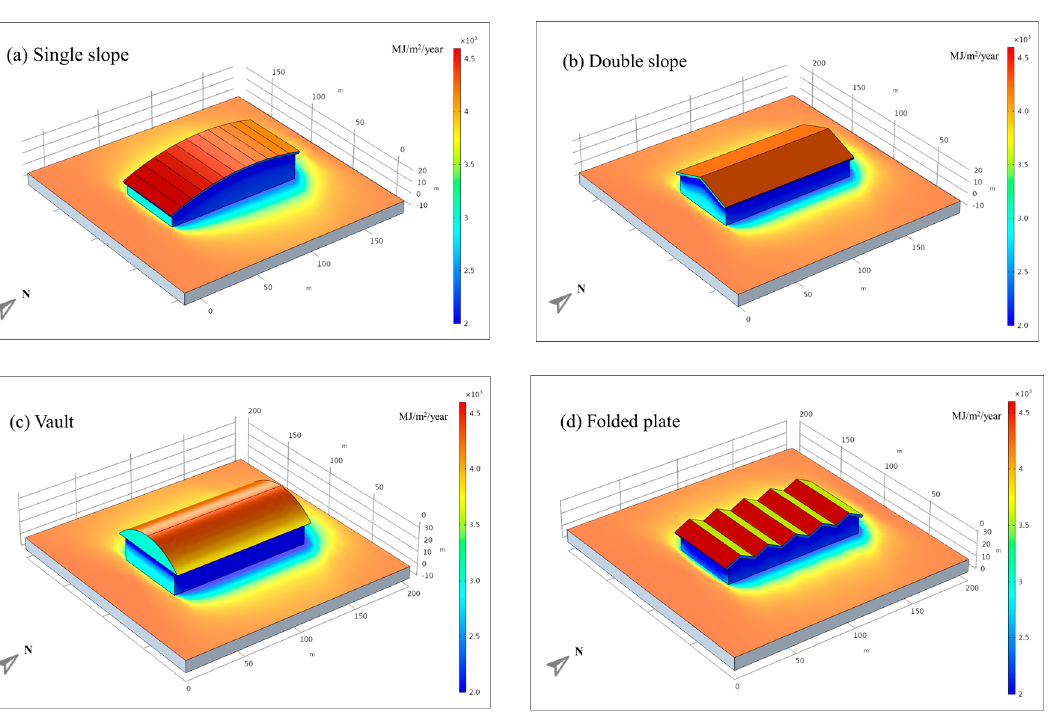
Figure 12. Annual solar radiation intensity of rectangular gymnasium buildings with the various roof shapes. ( a ) single slope; ( b ) double slope; ( c ) arch; ( d ) folded plate.